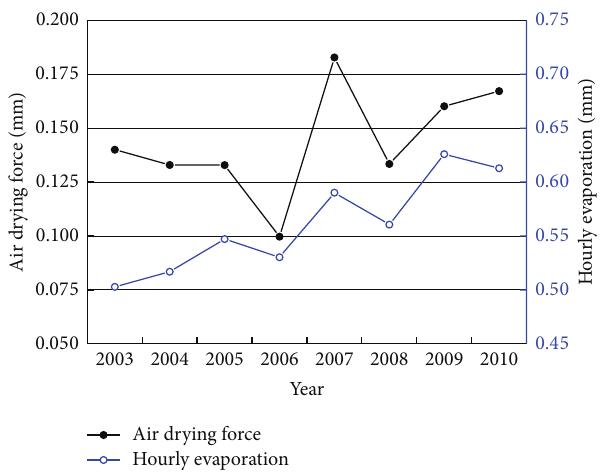
Figure 6: The variation trends of annual mean of 1-hour (13:10– 14:10) air drying force and hourly evaporation in Dongping Lake during2003–2010(opencirclemeanshourlyevaporation,dotmeans air drying force).